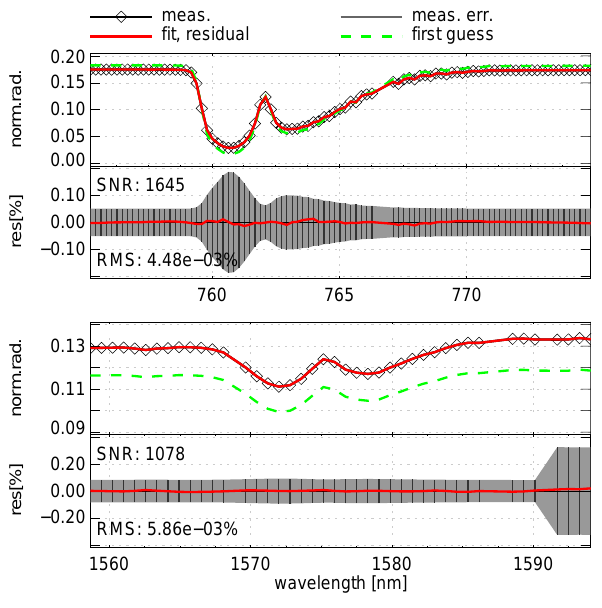
Fig. 7. O 2 and CO 2 fit windows with simulated measurements, first guess, fitted sun-normalized radiation, residual and simulated measurement uncertainty for the “met. 1 σ ” scenario at 40 ◦ solar zenith angle.